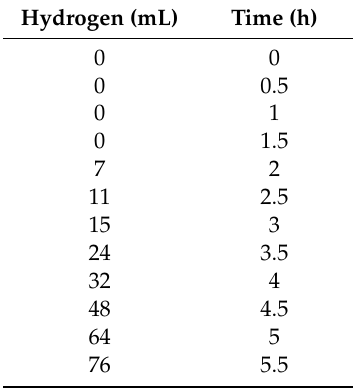
Figure 13. Graph representing relation between hydrogen gas produced and time during charging of proton battery. Table 8. X and Y axis variable values of the active points shown in Figure 13.